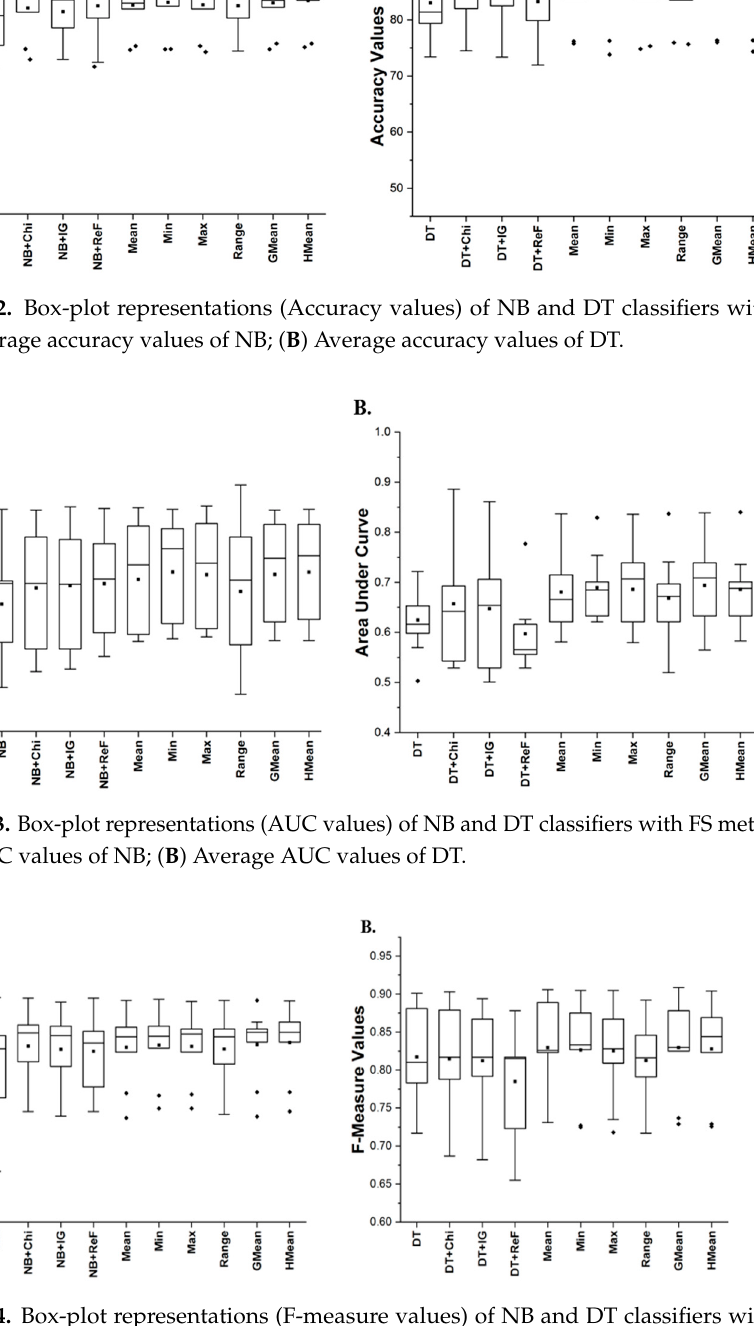
Figure 4. Box-plot representations (F-measure values) of NB and DT classifiers with FS methods. ( A ) Average f-measure values of NB; ( B ) Average f-measure values of DT.